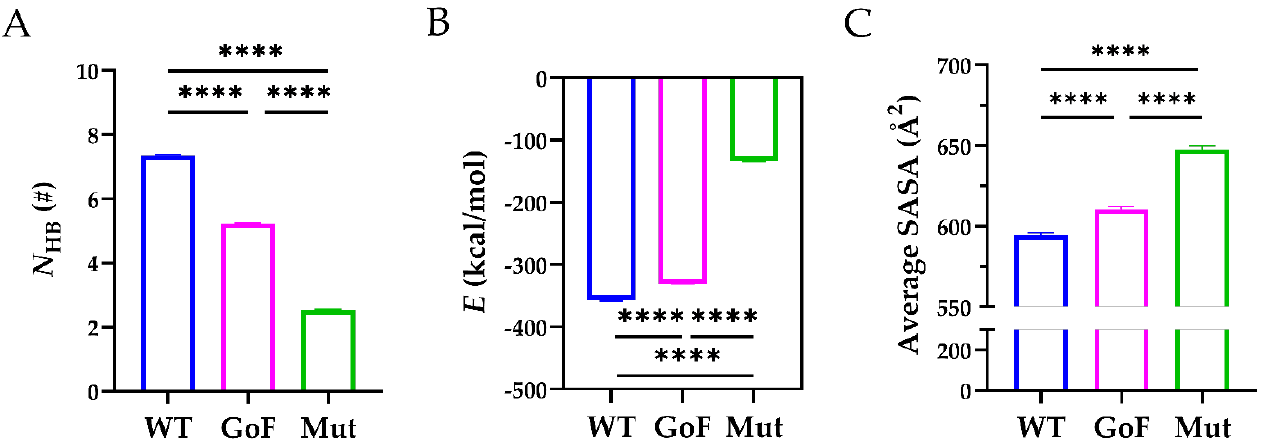
Figure 7. Comparisons of the WT, GoF, and Mut complexes. ( A ) The mean N HB , ( B ) the mean E , and ( C ) the average SASA across the interface of the WT (blue), GoF (magenta), and Mut (green) complexes. One-way ANOVA with a Bonferroni post hoc test was used to analyze the difference (**** indicates p < 0.0001, n = 3).